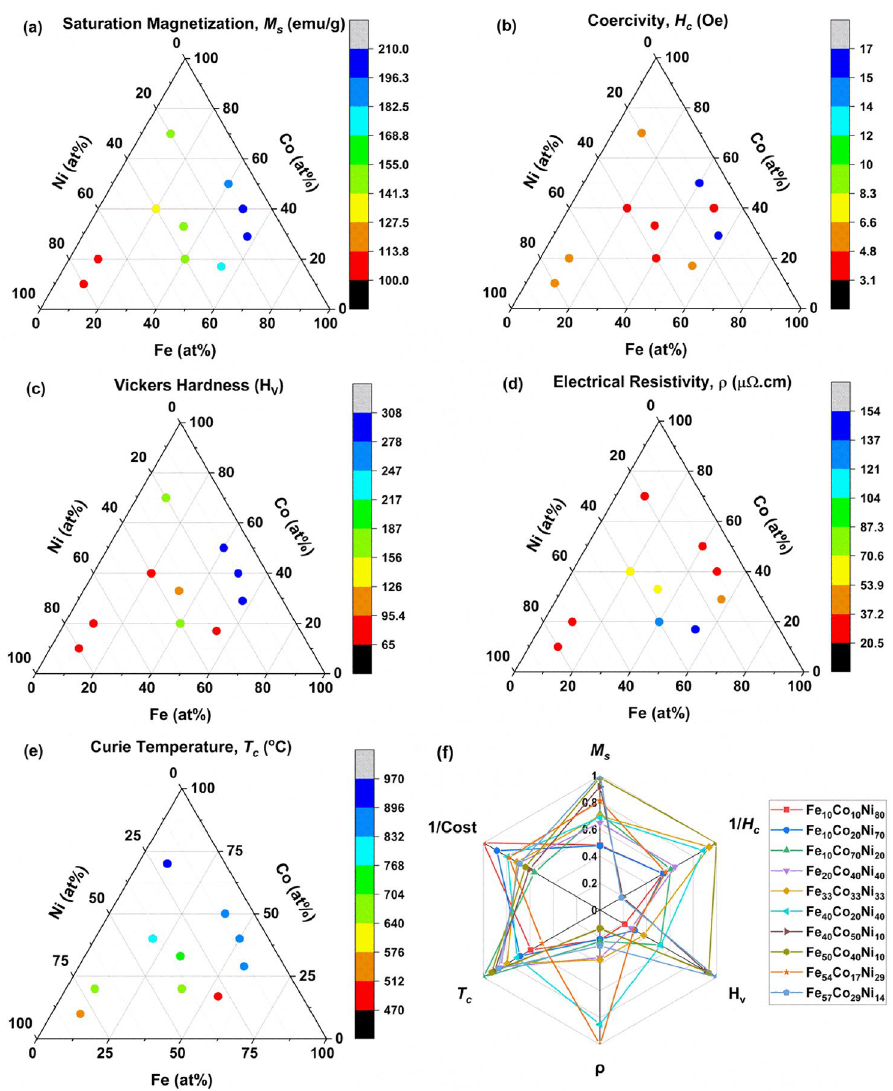
Figure 8. Colour maps of ( a ) saturation magnetization, M s , ( b ) coercivity, H c , ( c ) Vickers hardness, H v , ( d ) electrical resistivity, ρ, ( e ) Curie temperature, T c , for various compositions, and ( f ) radar plot for the materials properties and